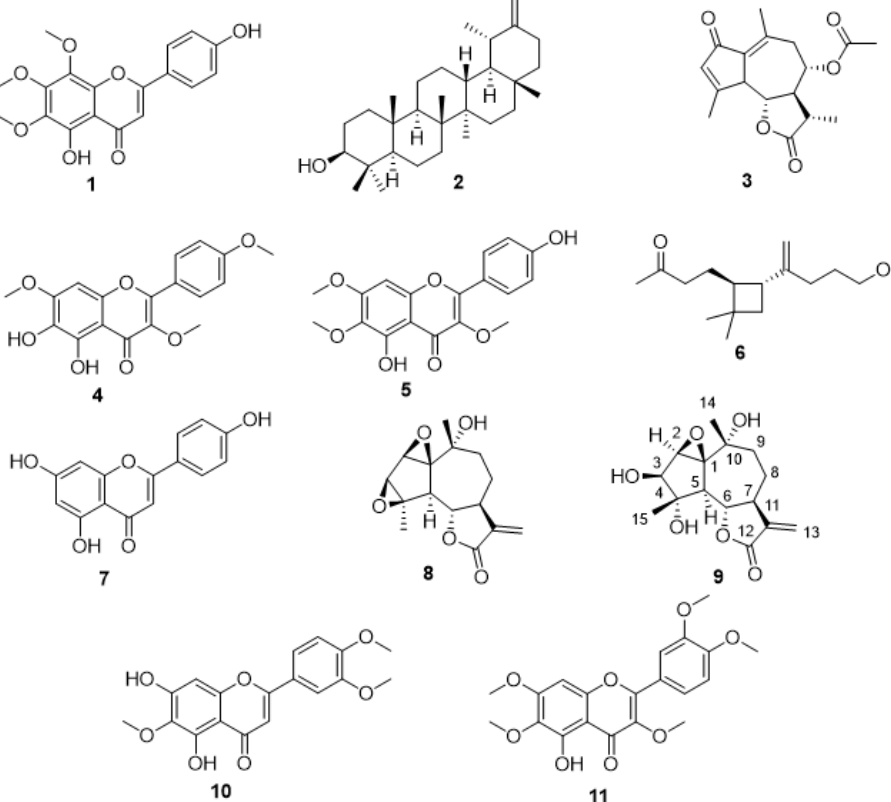
Figure 1. Musk yarrow constituents identified: xanthomicrol 1 , taraxasterol 2 , matricarin 3 , tanetin 4 , penduletin 5 , 1(10)-secocariophyllane 6 , apigenin 7 , canin 8 , 1 α ,2 β -epoxy-3 β ,4 α ,10 α -trihydroxyguaian 6 α ,12-olide 9 , eupatilin 10 , artemetin 11 .